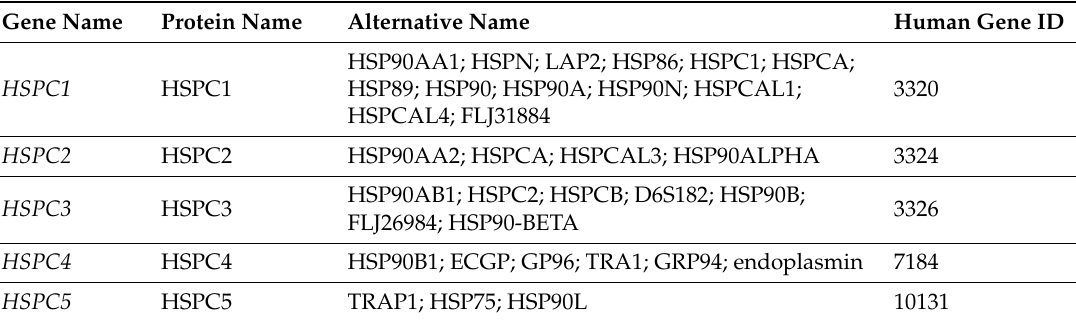
Table 1. Different members of human HSPC (HSP90) family